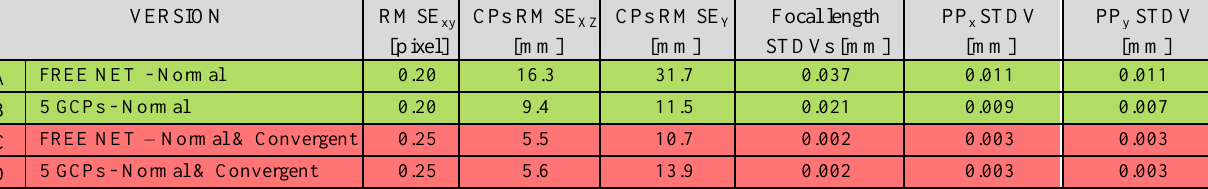
Table 1: RMSE of image observations and check points (CP) and STDV of interior parameters (focal length, x-coordinate PPx and y- Normal imaging